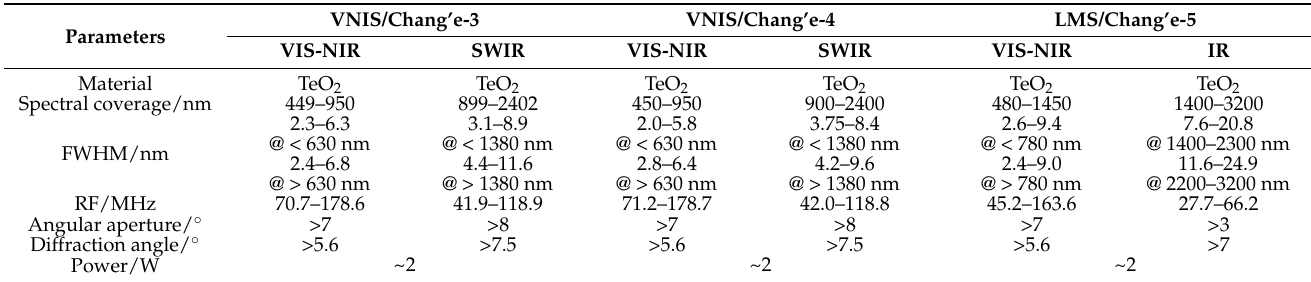
Table 2. Main performance parameters of VNIS and